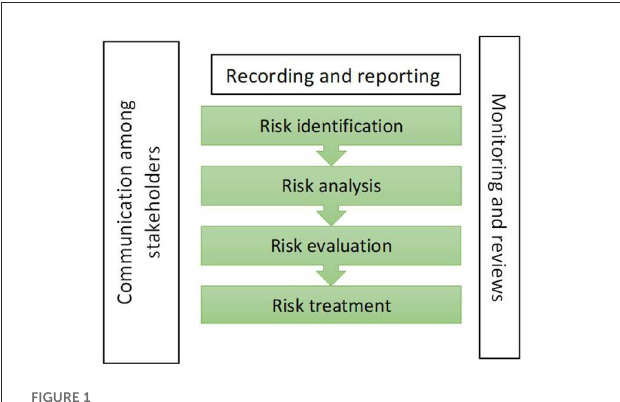
FIGURE1 The elements of the risk management